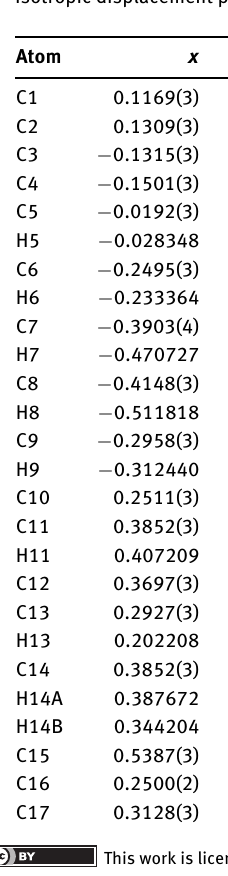
Table 2: Fractional atomic coordinates and isotropic or